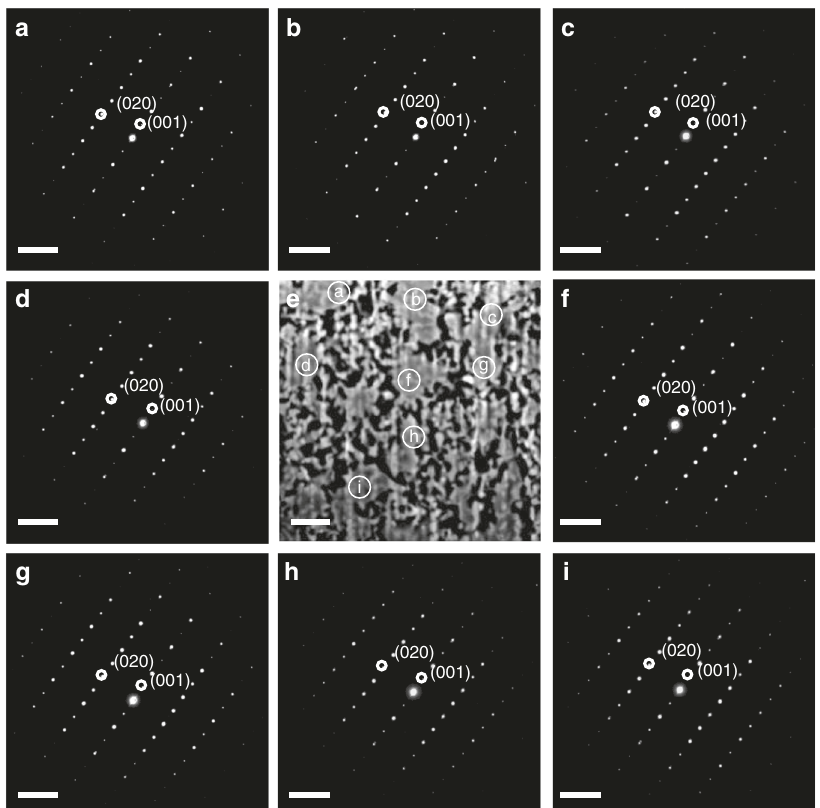
Fig. 2 Cross-sectional view and selected area electron diffraction. The a – d and f – i present the SAED pattern at different locations on the cross-section of the porous single-crystalline MoN. The e represents the cross-sectional view of the porous single-crystalline MoN with the locations for SAED patterns labeled. The data is recorded with the porous single-crystalline MoN grown on the [001] PbMoO 4 substrate. The scale bar is 5 1/nm in a – d and f – i while the scale bar is 1 μ m in panel